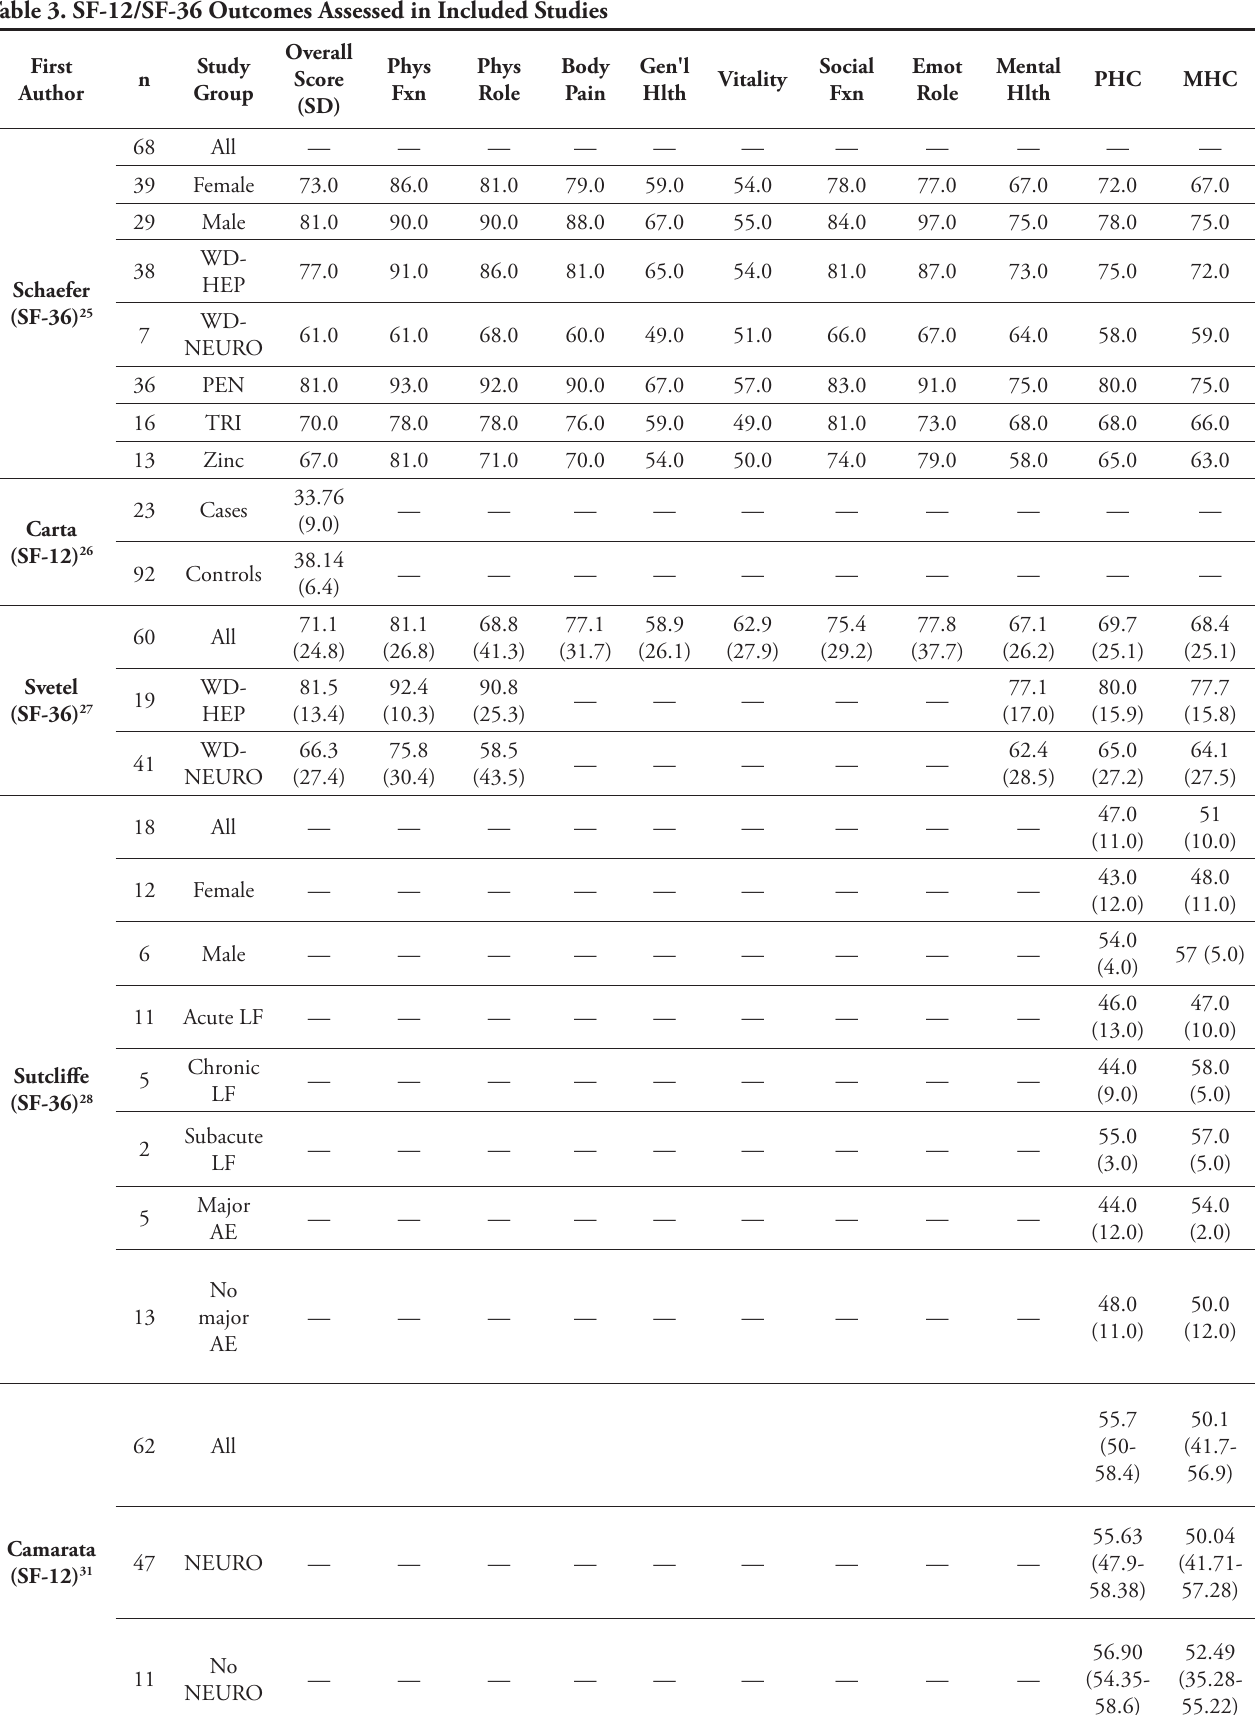
Abbreviations: AE, adverse event; Emot Role, emotional role; GAS, Global Assessment Scale; Gen'l Hlth, general health; PEN, penicillamine; PHC, physical health composite; Phys Fxn, physical function; Phys Role, physical role; Social Fxn, social functioning; TRI, trientine; WD-HEP, Wilson’s disease with predominant hepatic complications; WD-NEURO, Wilson’s disease with predominant neurologic complications; WHO-QOL-BREF, World Health Organization QOL Brief